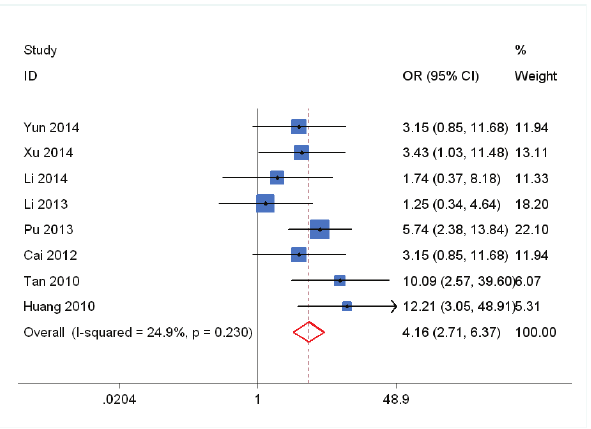
Figure 3: Forest plot of clinical efficacy for tripterygium glycosides in treatment of stage IV diabetic nephropathy. (The squares and horizontal lines demonstrate the study-specific OR and 95% CI. The area of the squares reflects the stud- specific weight (inverse of the variance). The diamond represents the pooled OR and 95% CI)